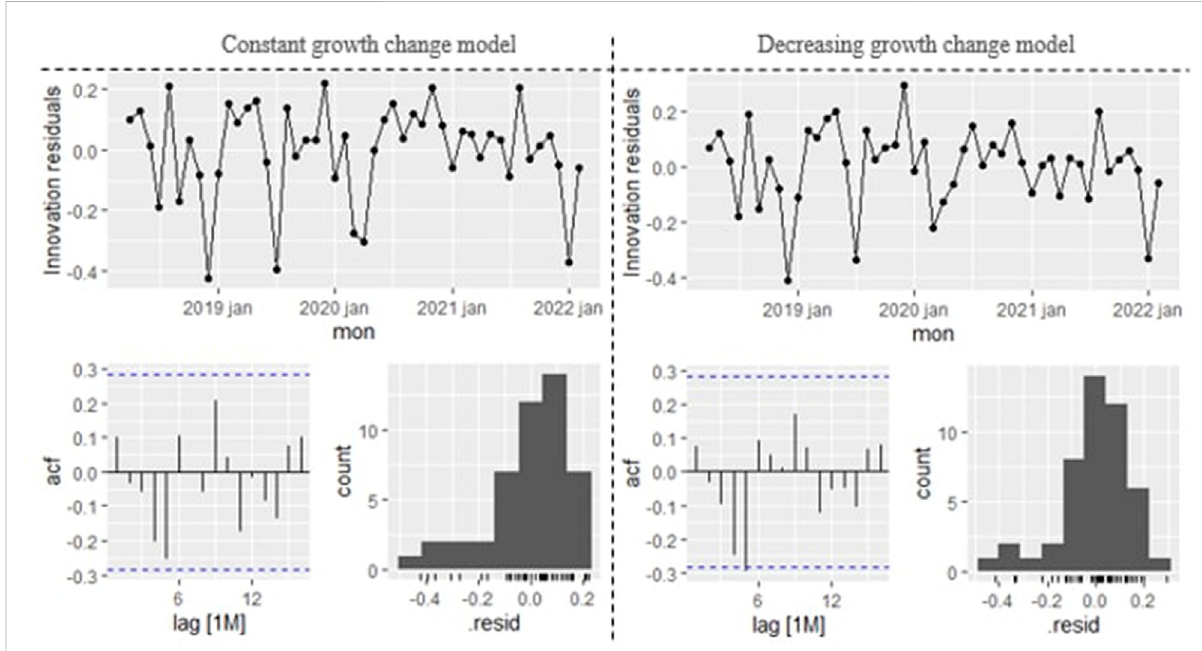
FIGURE 6 Residuals ’ diagnosis plots of the models (time series, autocorrelation function, and